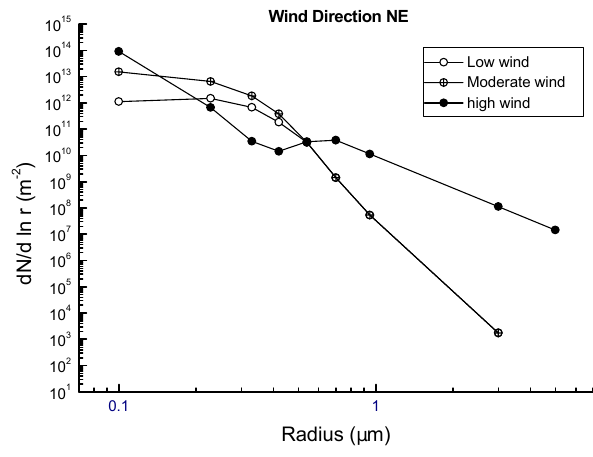
Fig. 9. Column integrated aerosol number density size distributions for northeast (NE) wind conditions.